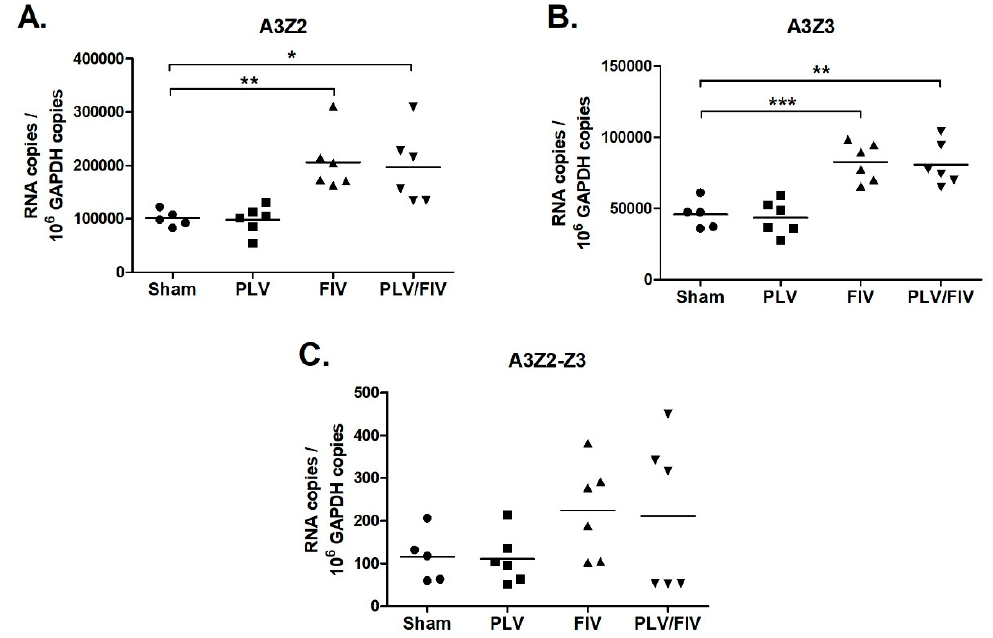
Figure 7. FIV-infected cats have increased A3Z2 and A3Z3 expression in thymus. Gene expression in cat thymus tissue was determined for A3Z2 ( A ), A3Z3 ( B ), and A3Z2-Z3 ( C ). Thymus from cats infected with FIV (FIV and FIV/PLV groups) had increased A3Z2 and A3Z3 mRNA compared to Sham-infected cats (***, p < 0.001; **, p < 0.01; *, p < 0.05). The trend toward greater A3Z2-Z3 expression in FIV-infected cats was not statistically significant. Lines indicate mean copy number for each